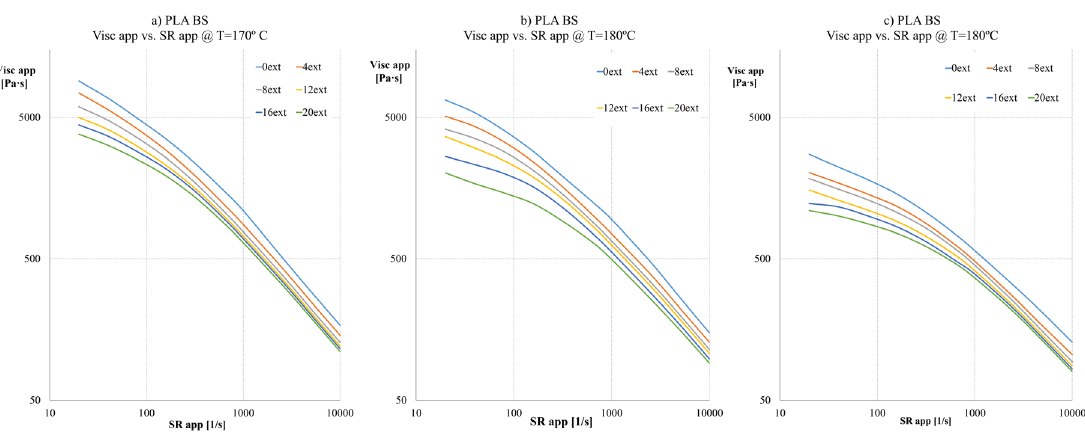
Figure 4. Apparent viscosity curves at different apparent Shear rates of each extrusion sample of: ( a ) PLA BS at 170 °C; ( b ) PLA BS at 180 °C; ( c ) PLA BS at 190 °C.